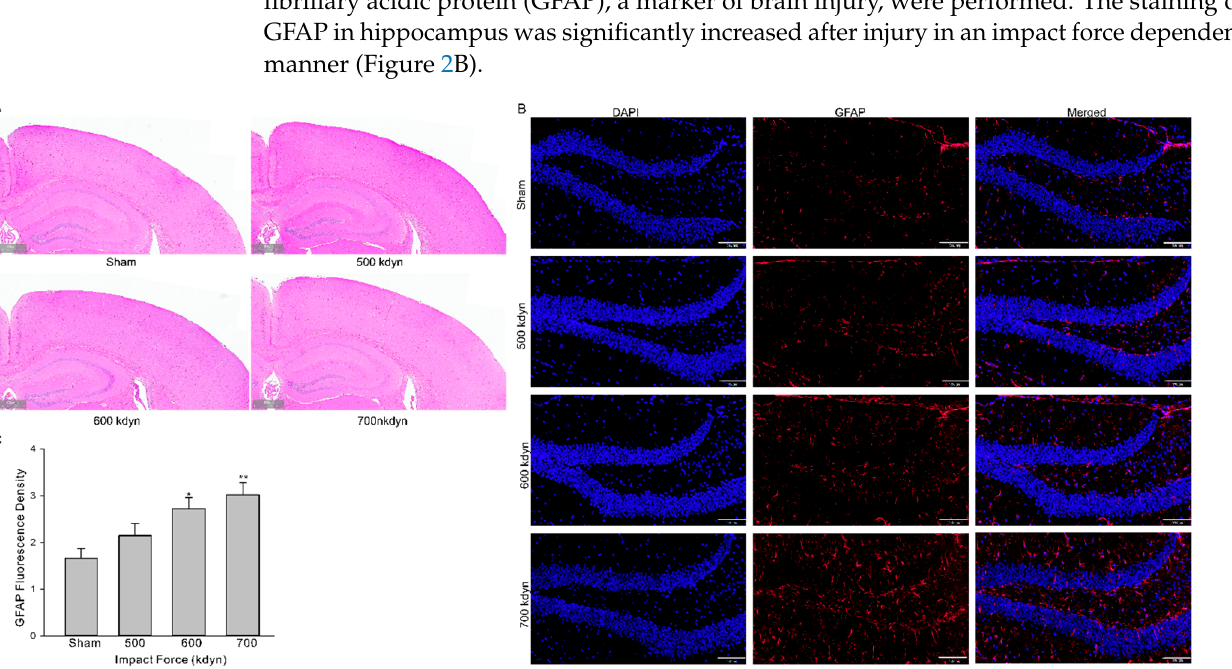
Figure 2. Histological analysis of the brain in the frontal cortex and hippocampus 2 h after mTBI with various impact forces. Sections were stained with hematoxylin and eosin ( A ) or GFAP ( B ). Scale bars indicate 500 μ m in ( A ) and 100 μ m in ( B ). ( C ) Summary data for ( B ). Data are presented as mean ± SEM. * p < 0.05, ** p < 0.01 compared to sham.